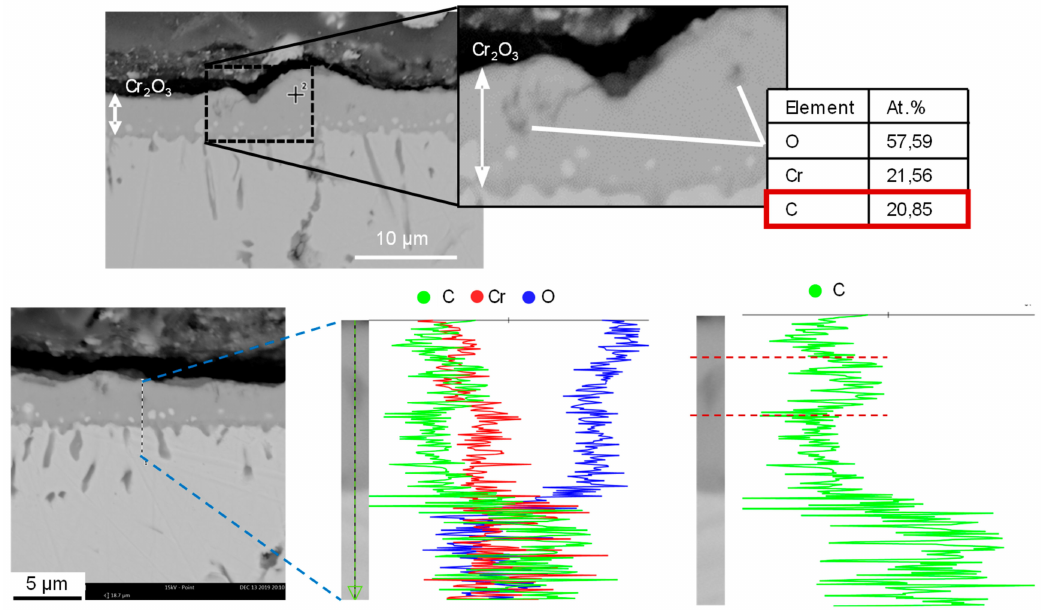
Figure 14. SEM cross section for Inconel 617 thermal annealing in DRESDEN-TANK: 100 h, 750 ◦ C, 6 MPa